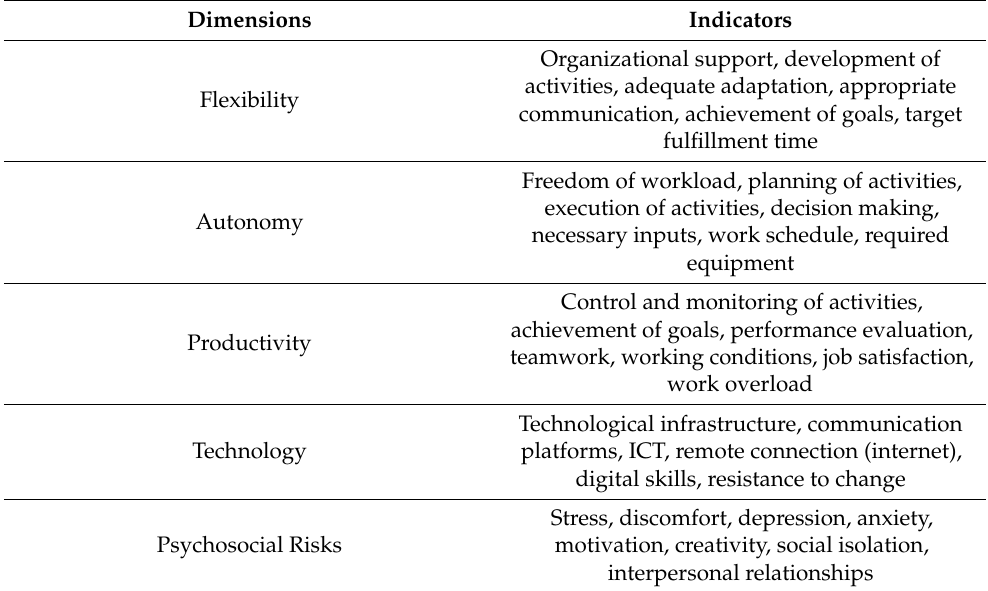
Table 2. Details of the dimensions and indicators of the remote work